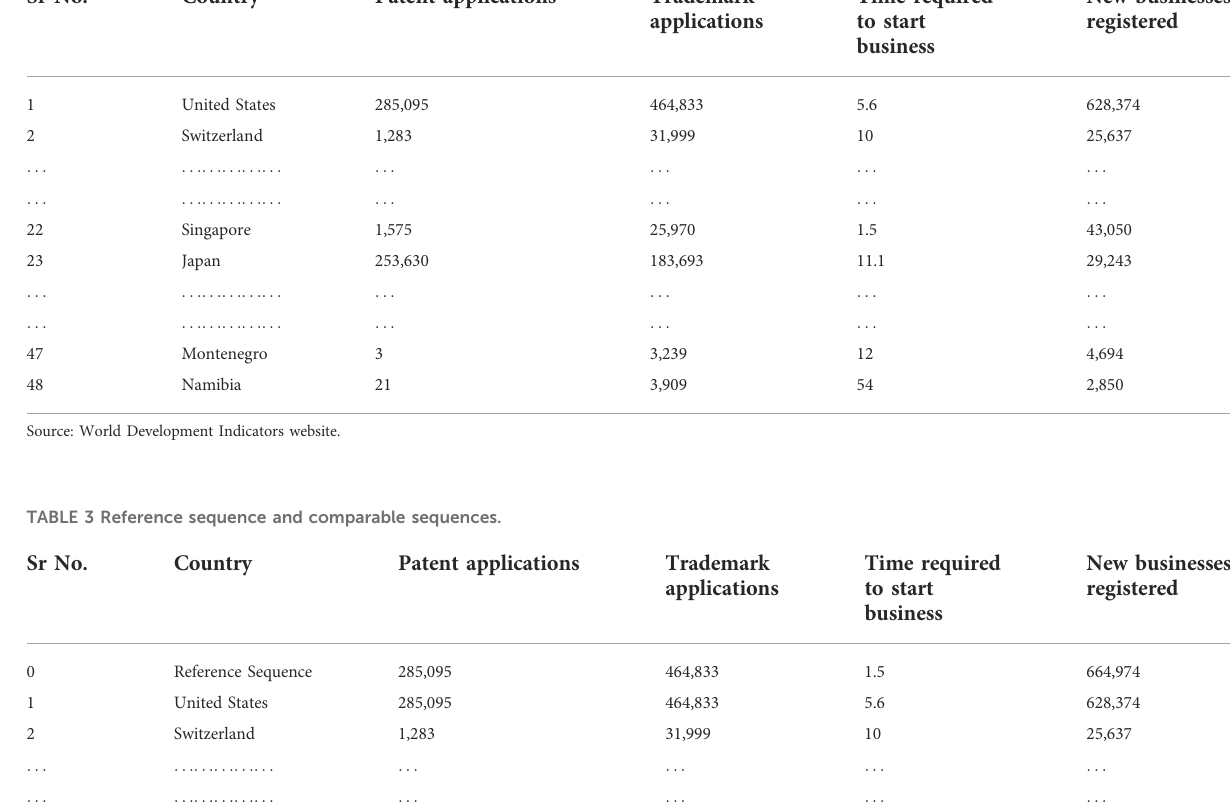
TABLE 2 Original country-wise data set. Sr No.